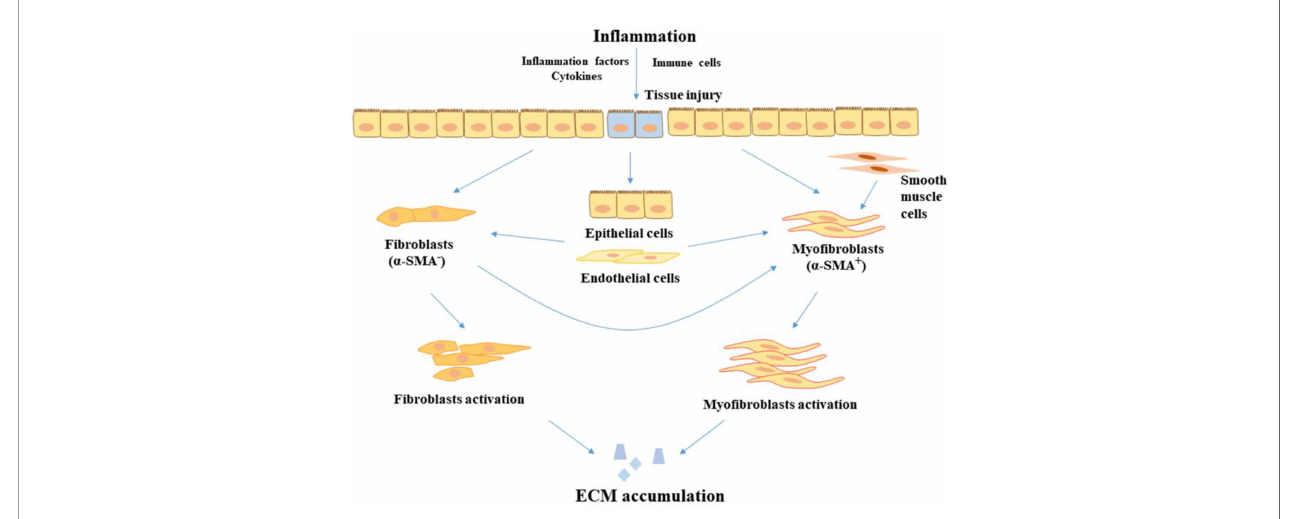
FIGURE 1 | The progression of fi brosis in IBD. In the in fl ammatory condition, tissue injury is stimulated by in fl ammatory factors and cytokines, leading to the proliferation and activation of fi broblasts in the intestine. In addition, epithelial cells and endothelial cells transition to mesenchymal cells. Fibroblasts and smooth muscle cells also transition to myo fi broblasts. Myo fi broblasts and fi broblasts accumulate the product of ECM, leading to the development of fi brosis. ECM, extracellular matrix; a -SMA, alpha-smooth muscle